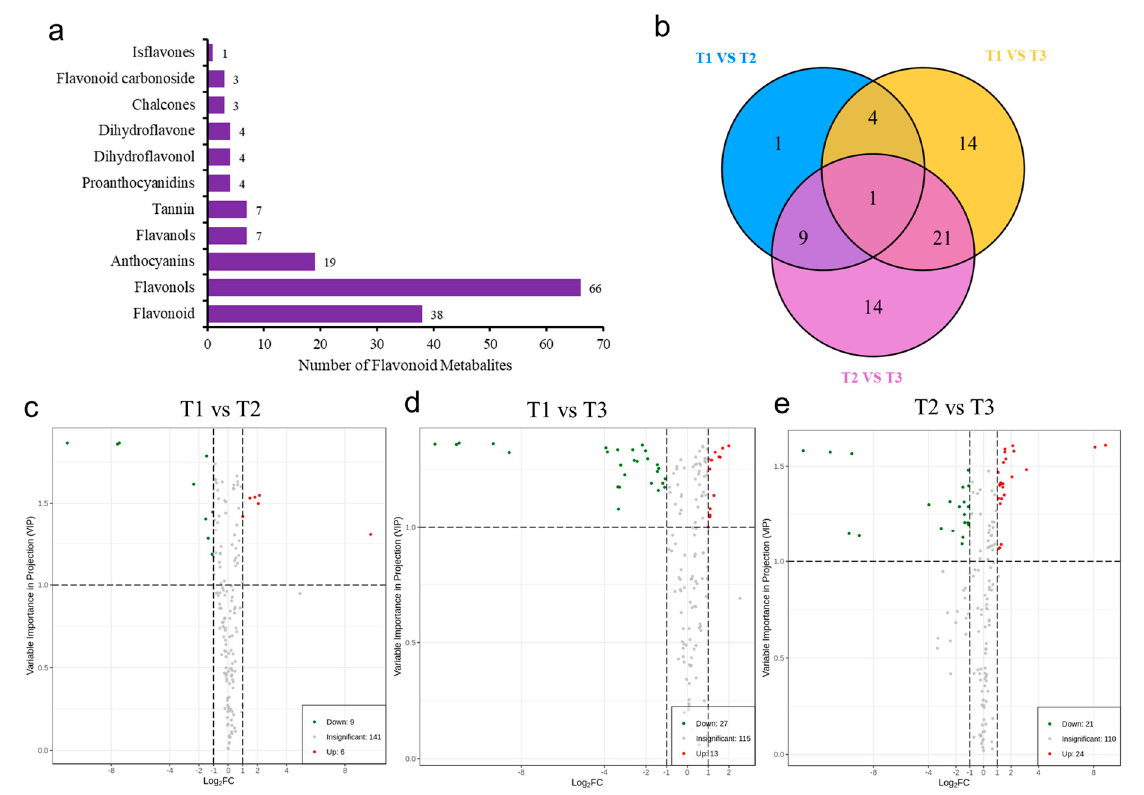
Figure 4. Analysis of flavonoid metabolites in Abelmoschus manihot L. ( a ) Types and quantities of metabolites. ( b ) Venn diagram of three HSK comparison groups. ( c – e ) Volcano plot of differentially accumulated metabolites (DAMs) in HSK at different flower development stages.